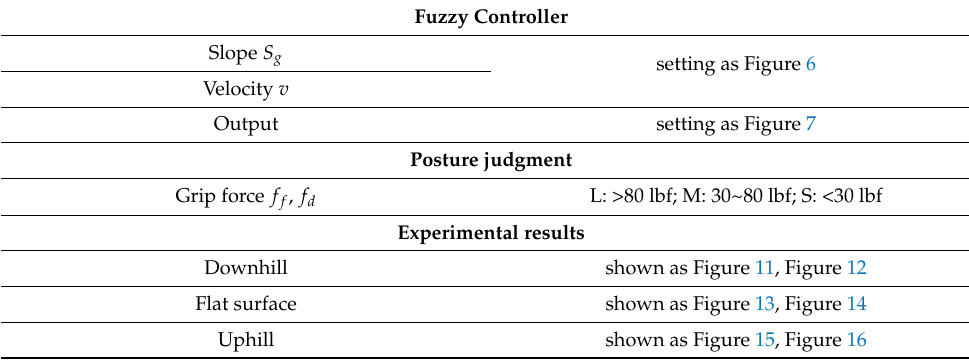
Table 8. Parameter settings and experimental